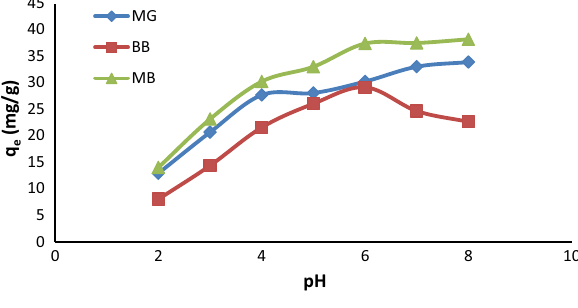
Fig. 4 Effect of temperature on the adsorption of Zn(II) Fig. 5 Effect of pH on the adsorption of